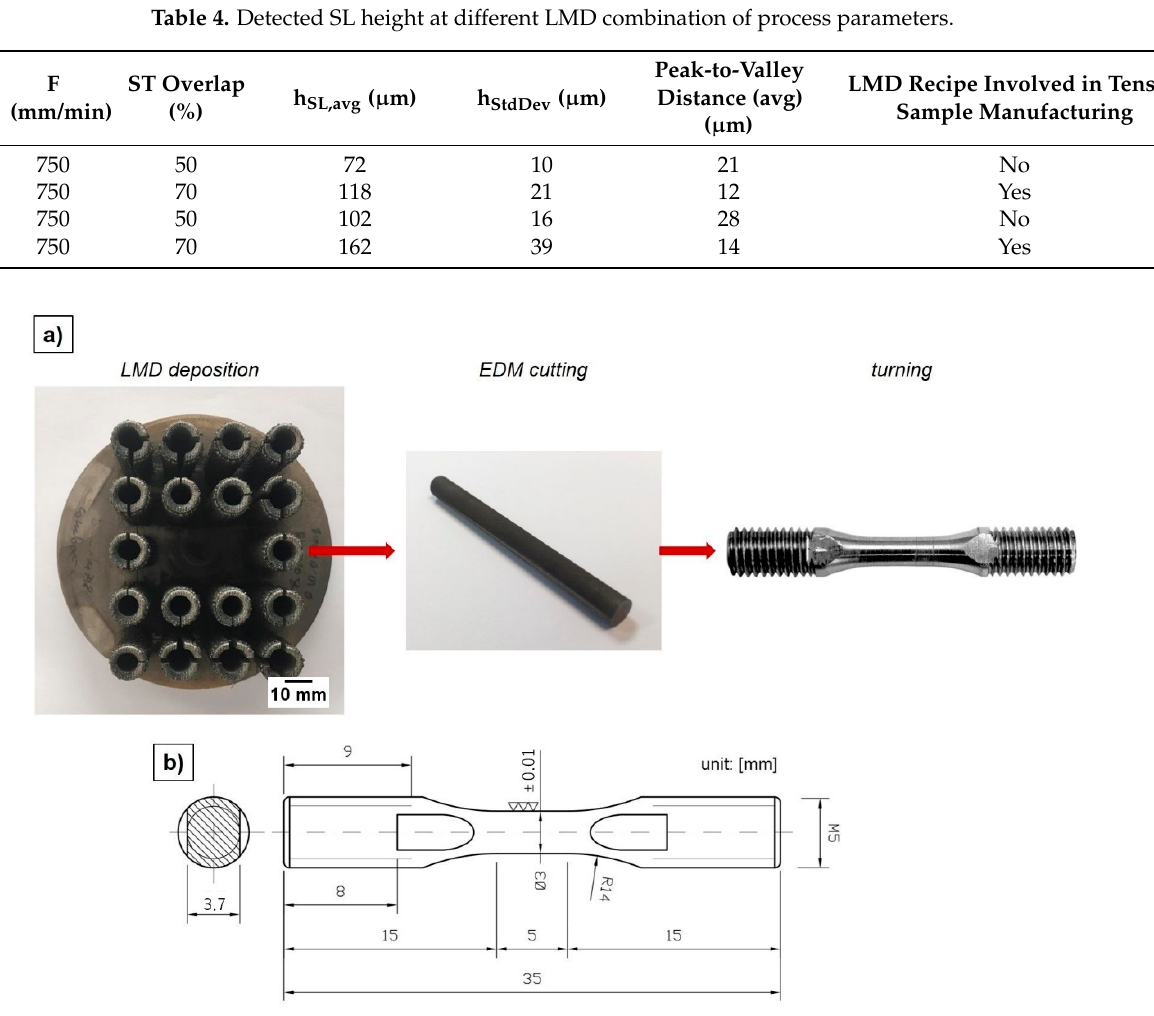
Figure 4. ( a ) tensile sample preparation from as-built Inconel 718 cylinders; ( b ) final tensile sample size and geometry.